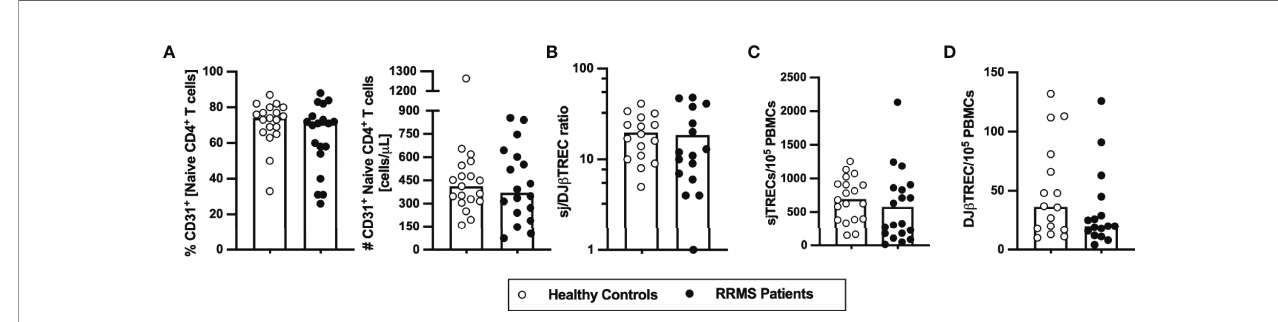
FIGURE 1 | Thymic export in newly diagnosed RRMS patients does not differ from healthy controls. Percentage and number of CD31 + naïve CD4 + T cells (A) . Ratio of sj/DJ b TRECs (B) calculated from the quanti fi cation of sjTRECs (C) and of DJ b TRECs (D) levels per 10 5 peripheral blood mononuclear cells (PBMCs). In all graphs, each dot represents one individual, and the horizontal lines represent the group ’ s mean or median, as the data follow a normal or non-normal distribution, respectively. Comparisons between healthy controls (white circles) and newly diagnosed RRMS patients (black circles) were performed using the t-test in (B) or the non-parametric Mann – Whitney U -test in (A, C, D) . Statistical outputs and effect size calculations in eTable 1 . Results are maintained upon controlling for sex, age, and human cytomegalovirus IgG seroprevalence on multiple linear regression models ( eTable